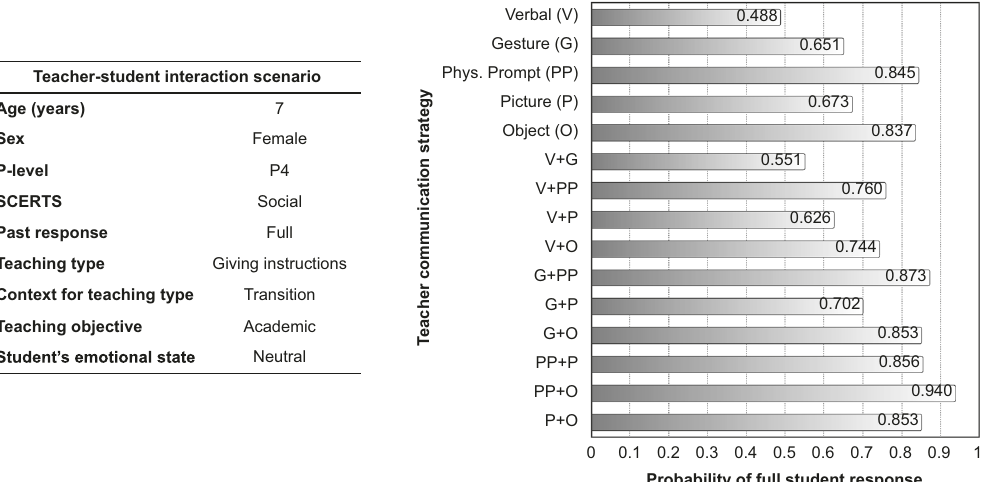
Fig. 2 An example of using the machine learning classi fi er for predicting the non-calibrated probability that one or more teacher communication strategies would result in a full student response. The scenario parameters are listed in the table on the left — note that the student pro fi le and the characteristics of this teacher-student interaction are both out-of-sample (i.e. not existent in the collected data). The chart on the right depicts the probabilities of full student response (for the interaction described on the left) for all single teacher communication strategies as well as all possible pairings of and the corresponding probability of full student response given process which remains unaffected. For a given teacher-student each possible teacher communication or pair of communications, interaction instance, we can change the input of the classi fi er such Pr full response j teacher communication(s) ð Þ , is presented on the that all the different communication strategies or pairs of them are right. These estimates were based on the best-performing model activated one at a time, and obtain a set of full student response (GP- α , τ = 1), trained on all the collected data. This particular probabilities each conditioned on the selected communication(s). scenario under investigation was not present in the collected data, We can then choose the one that has the greatest probability of i.e., it is a simulated observation (more examples are provided in generating a full student response. That way our model can produce Supplementary Table 2). In this example, the next best communica- teacher communication strategy suggestions for speci fi c teacher- tions to a physical prompt (that might not be a desirable student interaction cases. Figure 2 provides an example to showcase communication strategy) with quite strong probabilities of success this. The teacher-student interaction scenario is listed on the left,